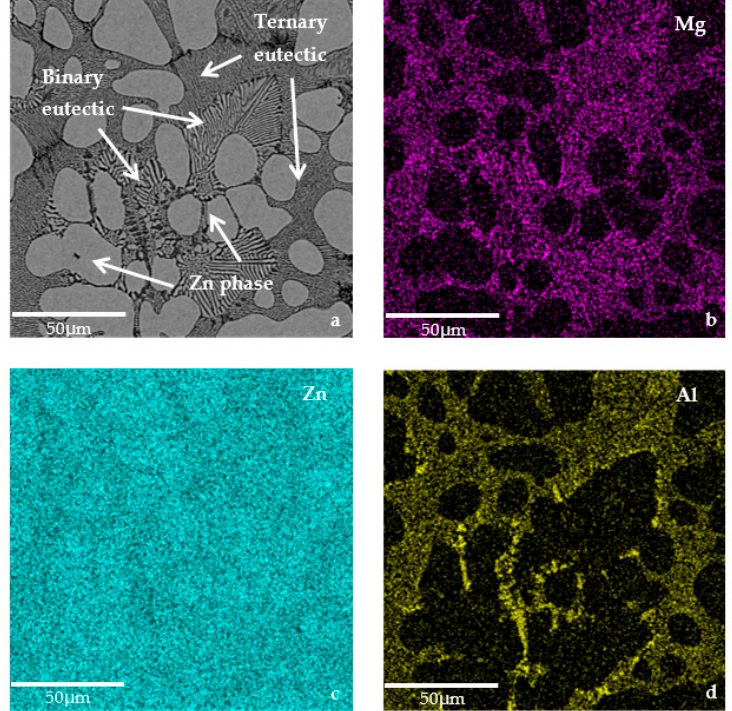
Figure 2. ( a ) SEM Surface Photos of Zn-1.6Al-1.6Mg coating and ( b – d ) EDS Analysis Results.